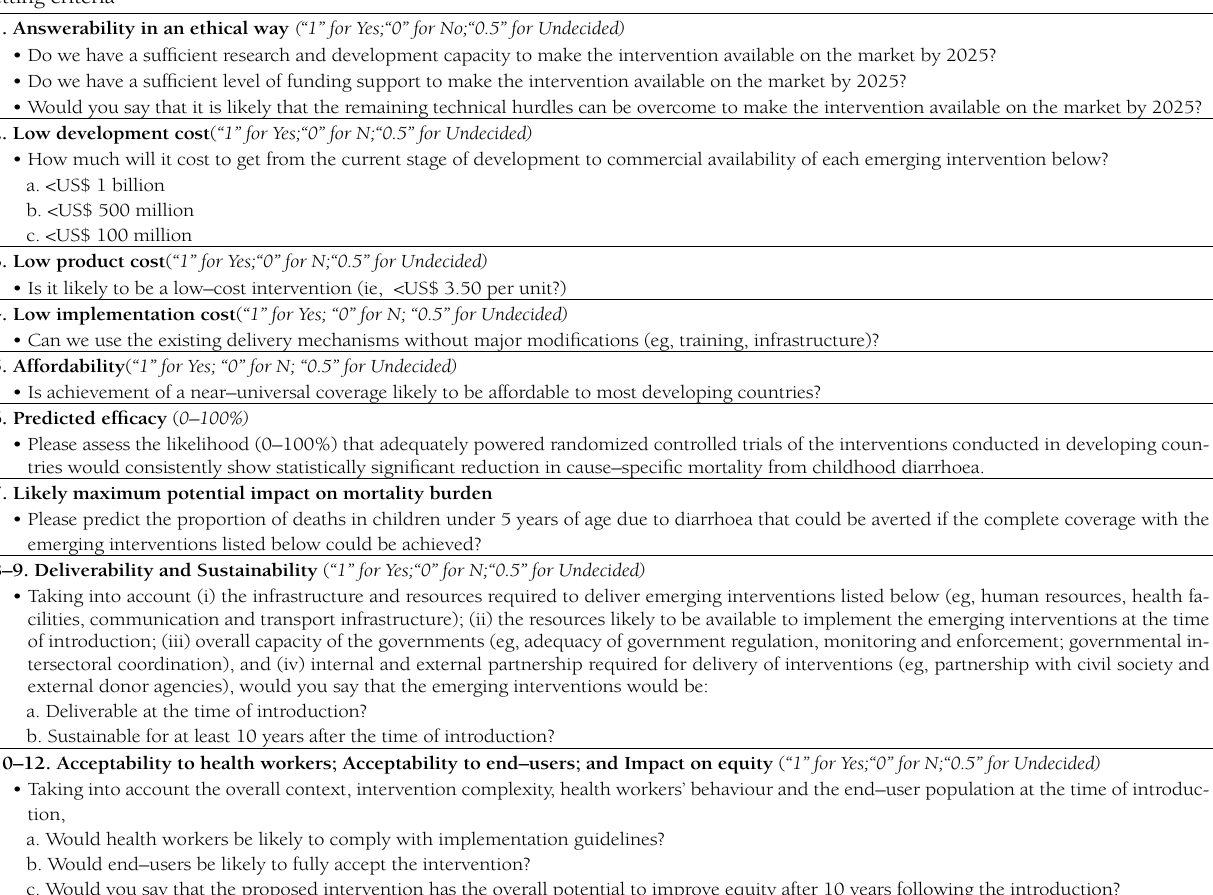
Table 2. Specific questions used to assess whether the proposed research themes (eg, emerging interventions) satisfy the 12 priority– setting